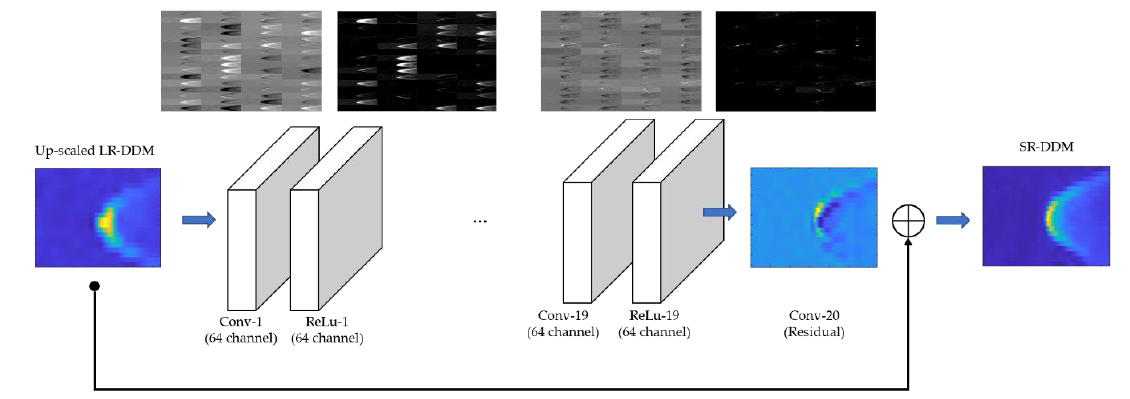
Figure 5. The structure of the very-deep super-resolution (VDSR) network.